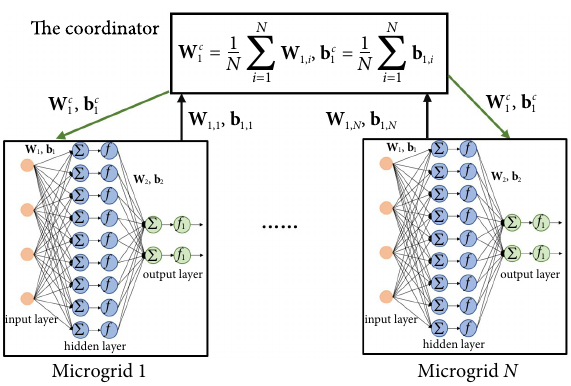
Fig. 3 Schematic of learning-based AFM for microgrids integration.